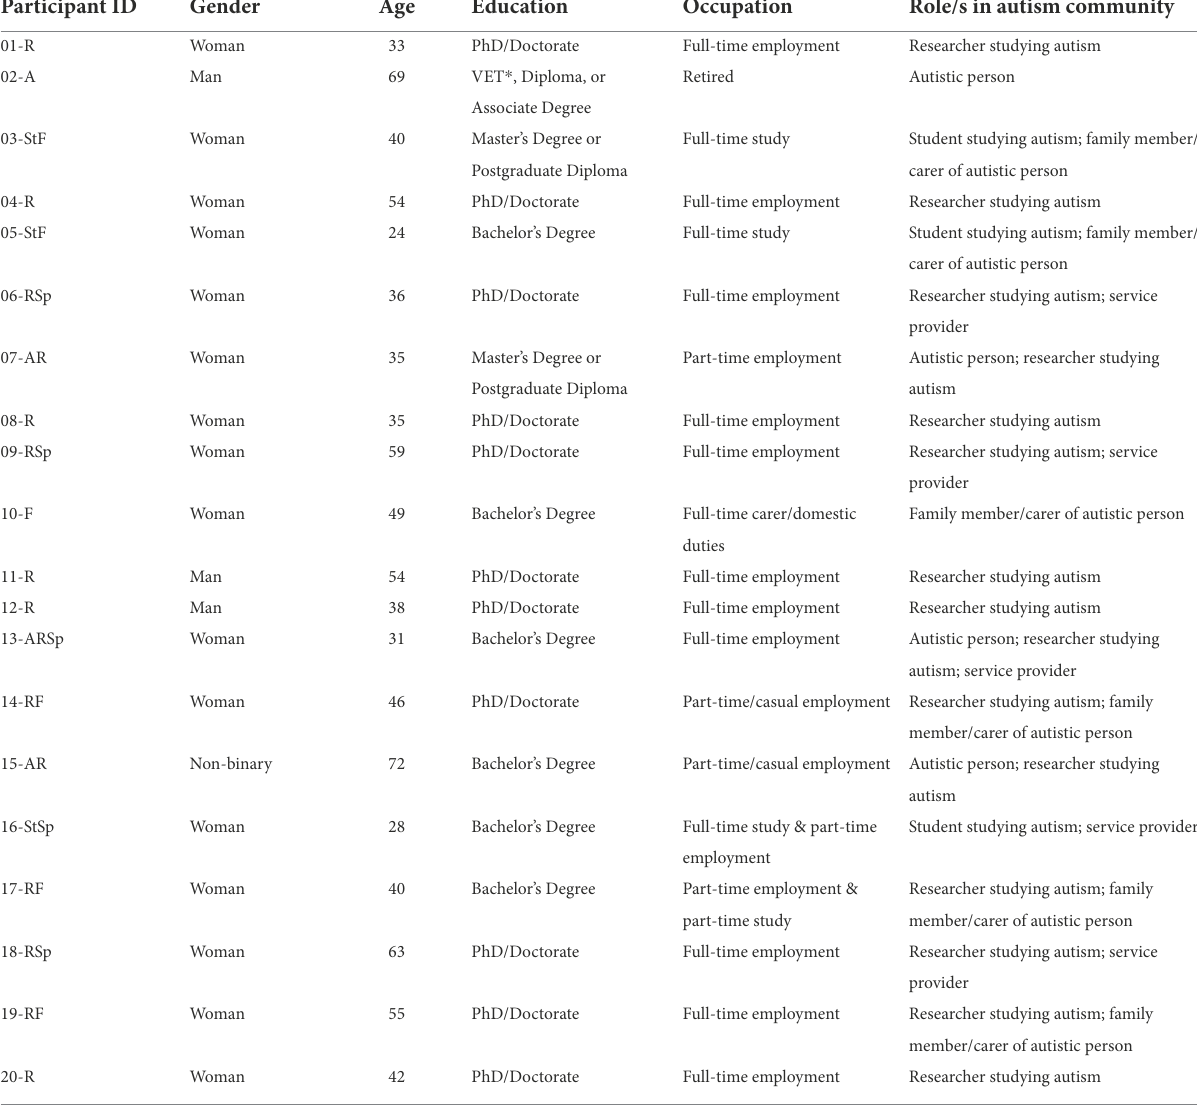
TABLE 1 Participants’ demographic